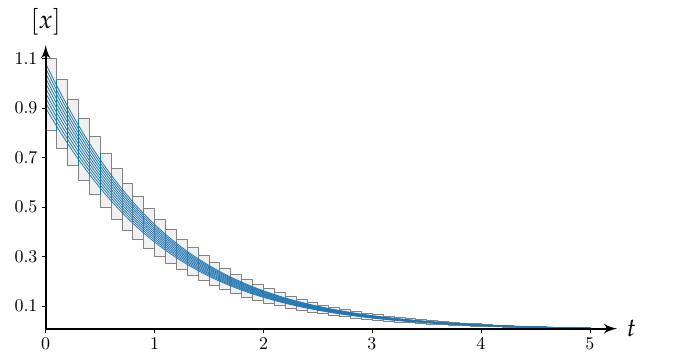
Figure 10. Differential constraint ˙ x = − sin ( x ) applied using C Lohner .